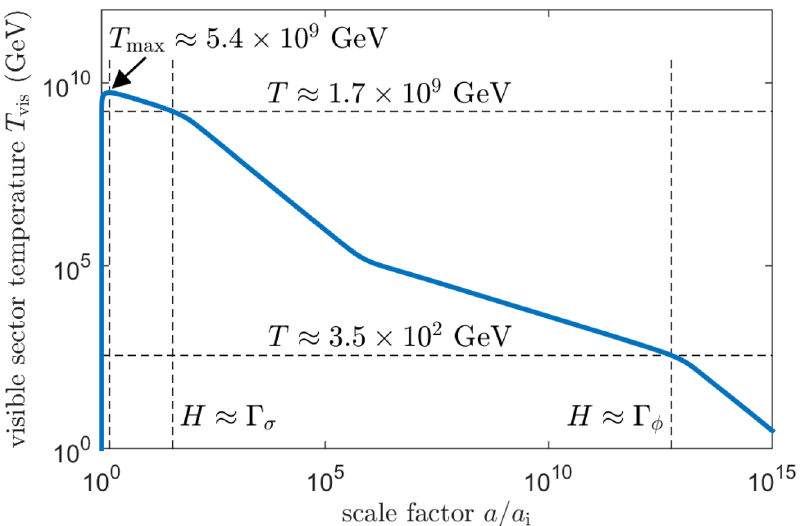
Figure 6 . Evolution of the visible sector temperature as a function of scale factor in the cosmo- logical history of figure